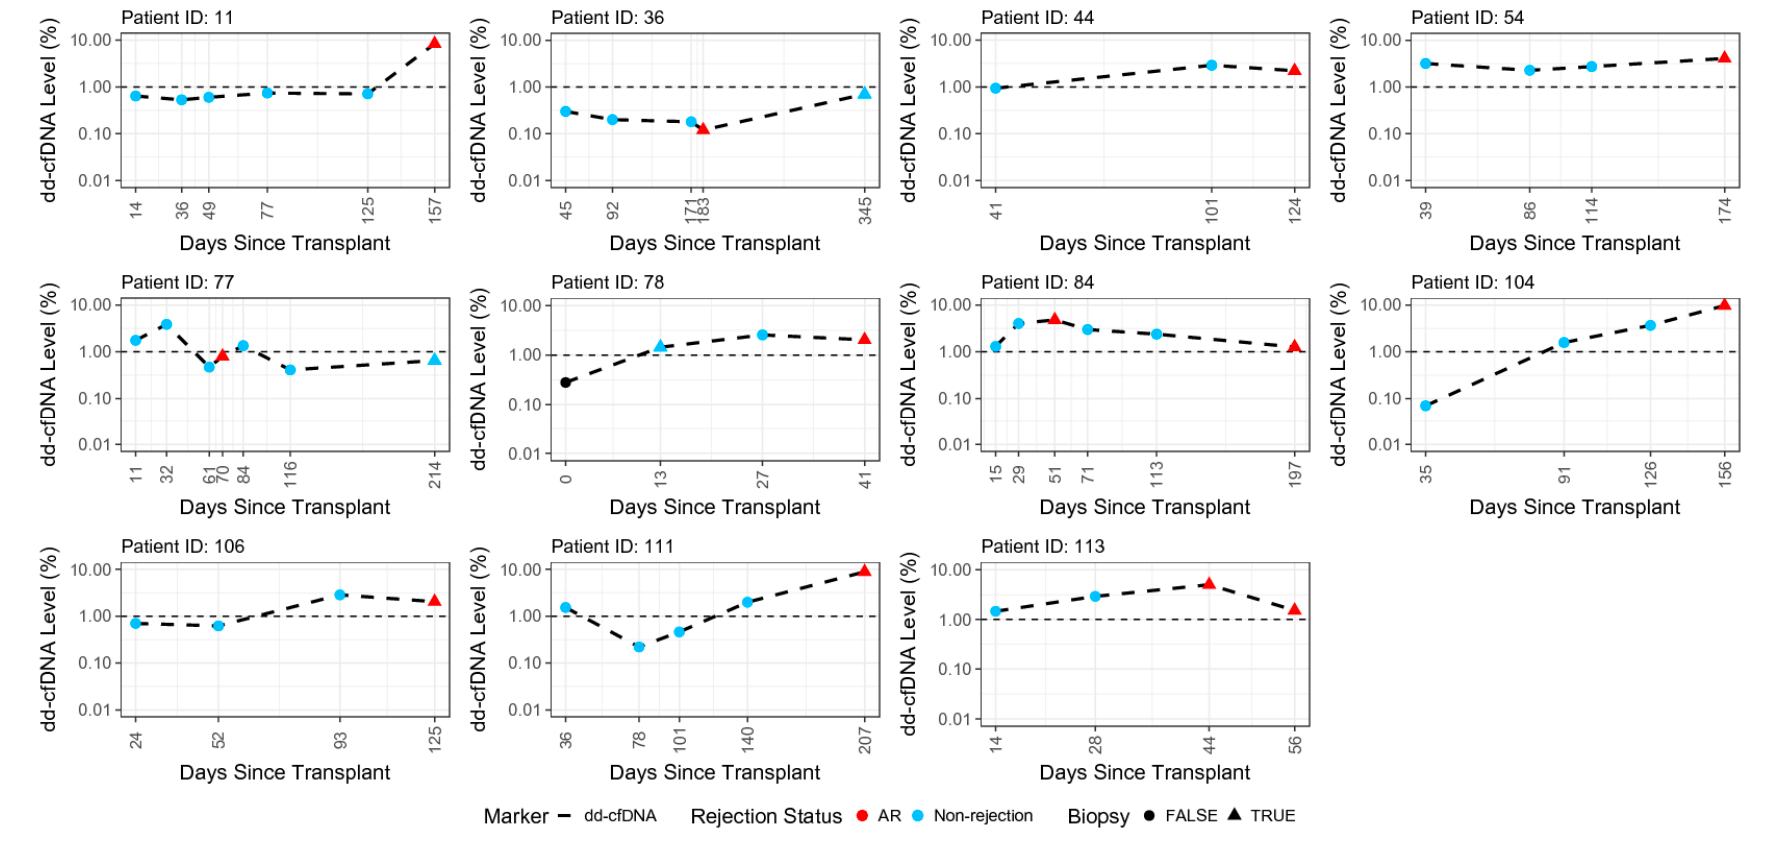
Figure 7. Variability in dd-cfDNA in non-rejection patients over time. ( A ) Inter-patient variability (60 samples from 60 patients over time); ( B ) intra-patient variability (samples from the same 10 patients over time); ( C ) change in dd-cfDNA levels over time in patients with active rejection. AR, active rejection; BL, borderline; OI, other injury; STA, stable.